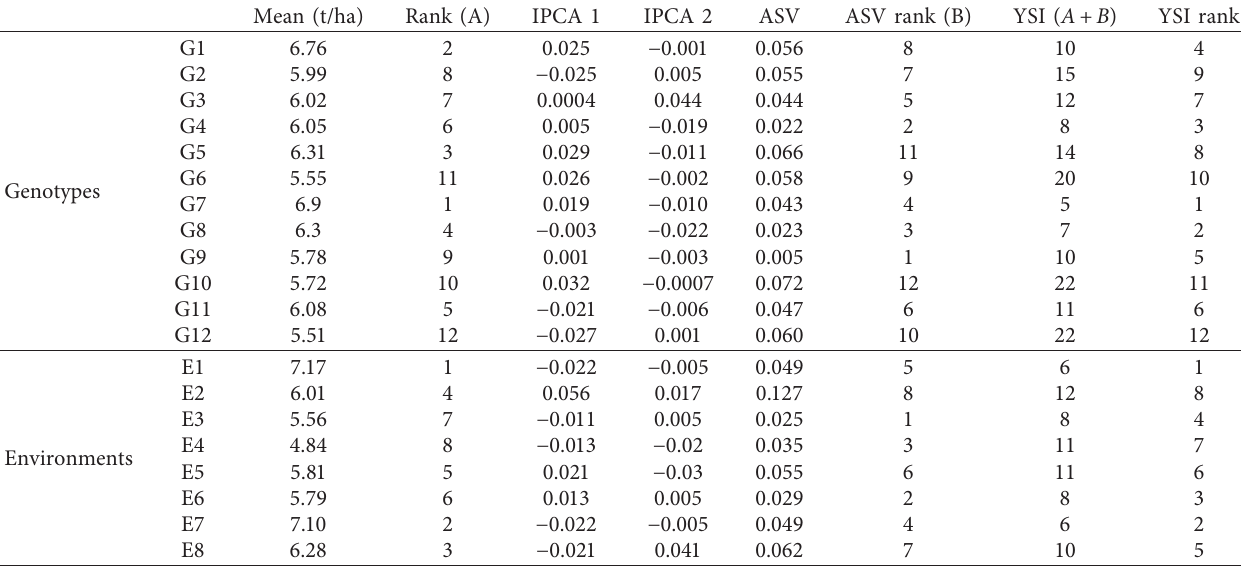
Table 4: Ranking of 12 hybrids of maize and 8 environments based on the AMMI stability value (ASV).